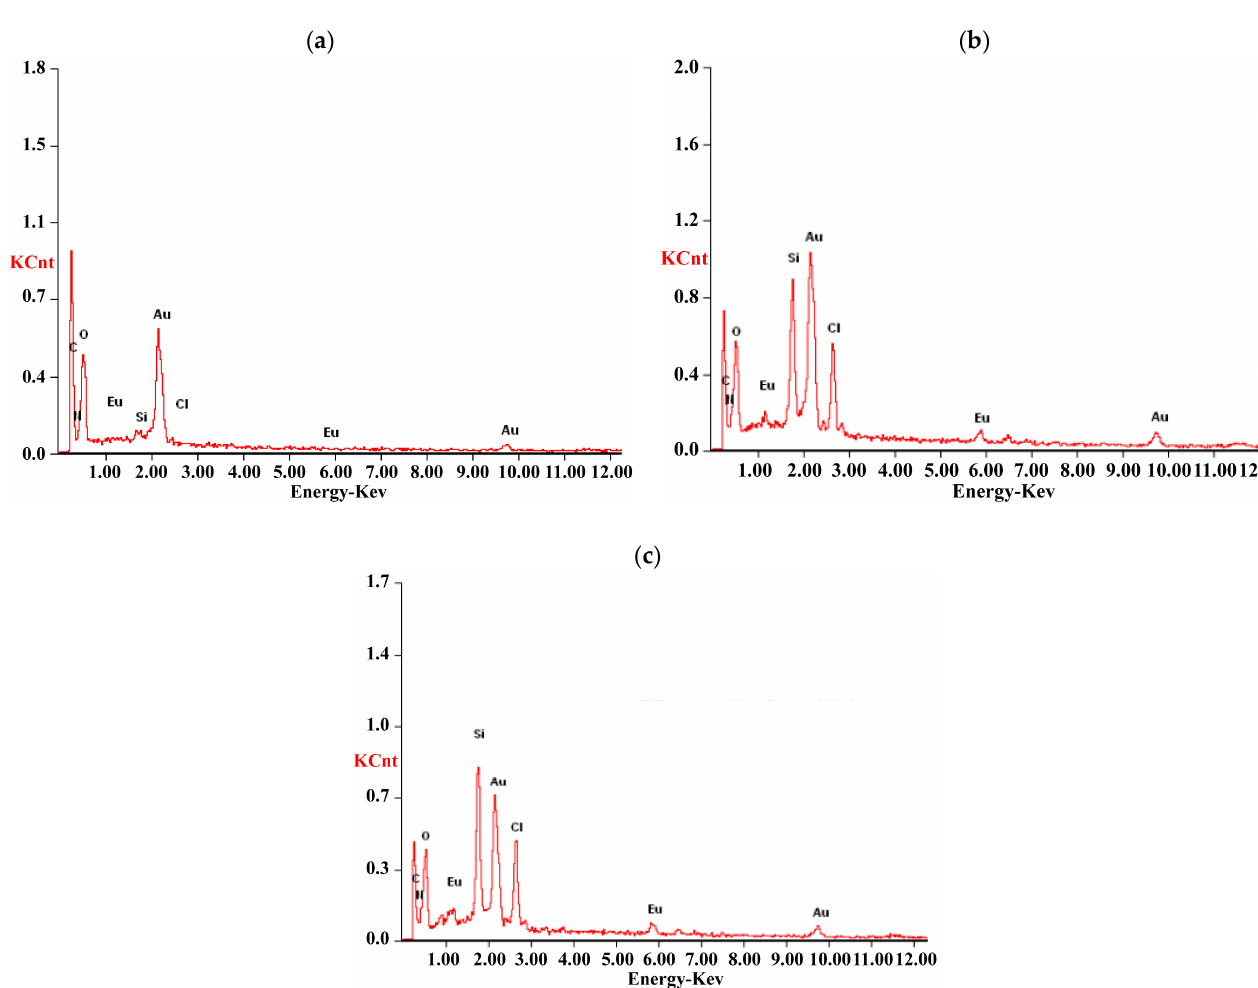
Figure 3. Energy Dispersive X-ray Analysis (EDXA) spectra of ( a ) the untreated wood, ( b ) the sol coating composite, ( c ) and the sol coating composite under UV light radiation (340 nm) for 480 h.